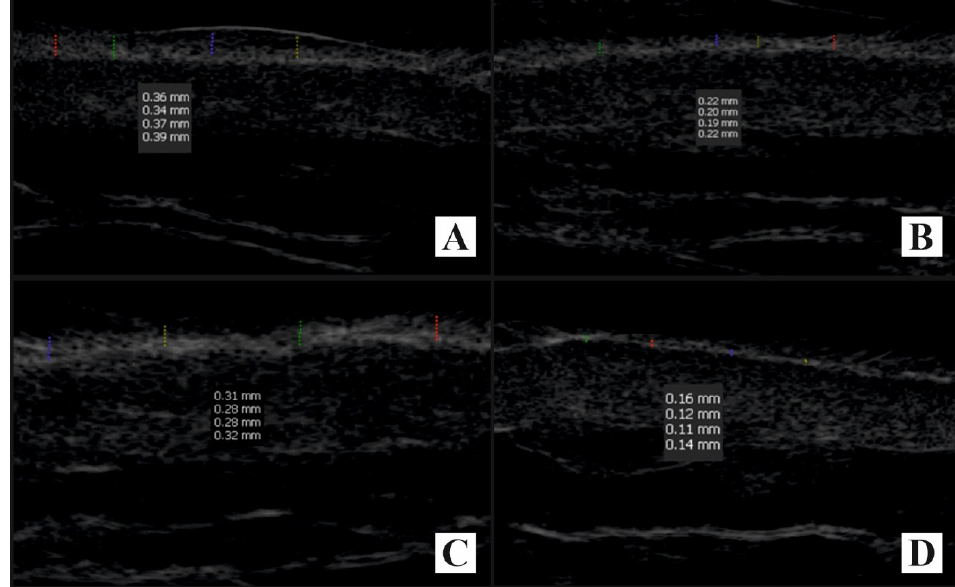
Figure 1. The epidermis thickness expressed in mm before ( A , C : mean value 0.37 mm and 0.30 mm, respectively) and after ( B , D : mean value 0.21 mm and 0.13 mm, respectively) stripping in two examined subjects. Table 1. ESI-MS results for a different concentration of taxifolin.